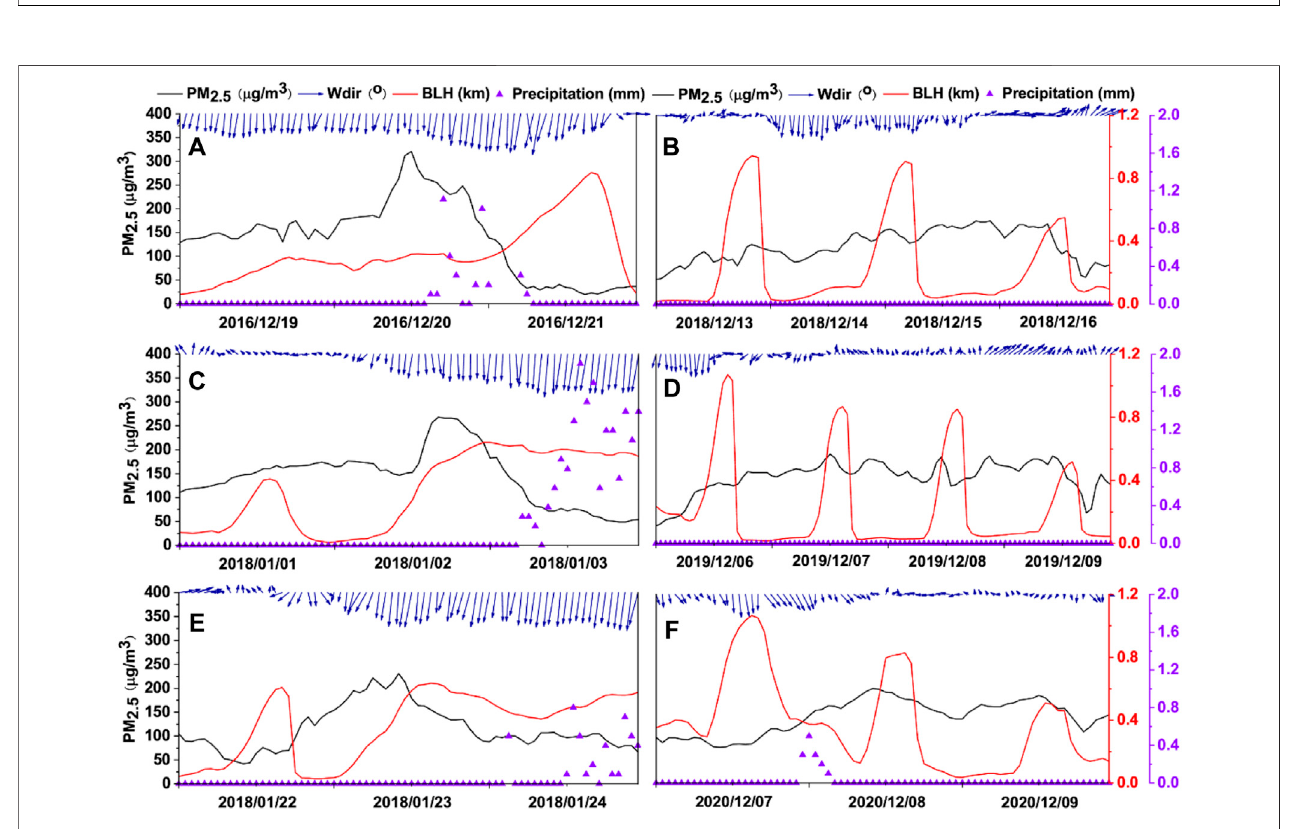
FIGURE 3 | Temporal changes in PM 2.5 concentration (black lines), PBLH (red lines), wind directions at 10 m (Wdir, vectors), and precipitation (purple triangles) were observed at JM in the THB. (A,C,E) Left column represents the three cases of RTT. (B,D,F) Right column represents the three cases of SAT.